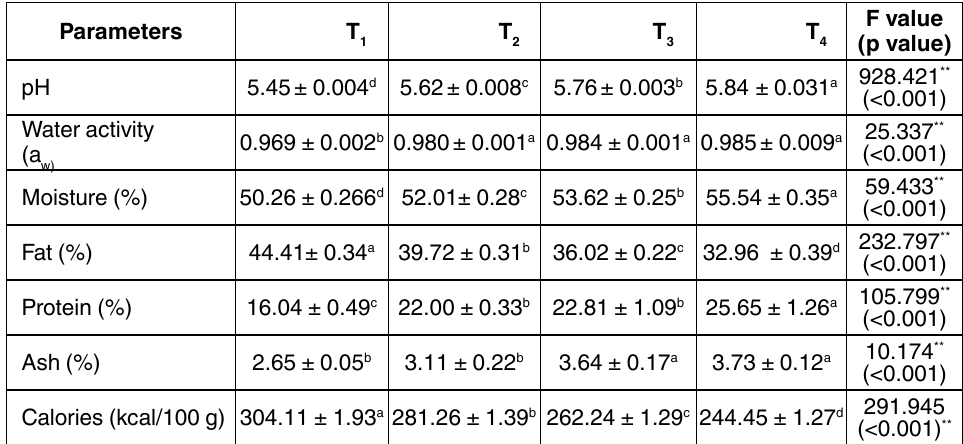
Table 2. Effect of different levels of mayonnaise and spent chicken on the physicochemical and proximate composition in the chicken meat spread Parameters